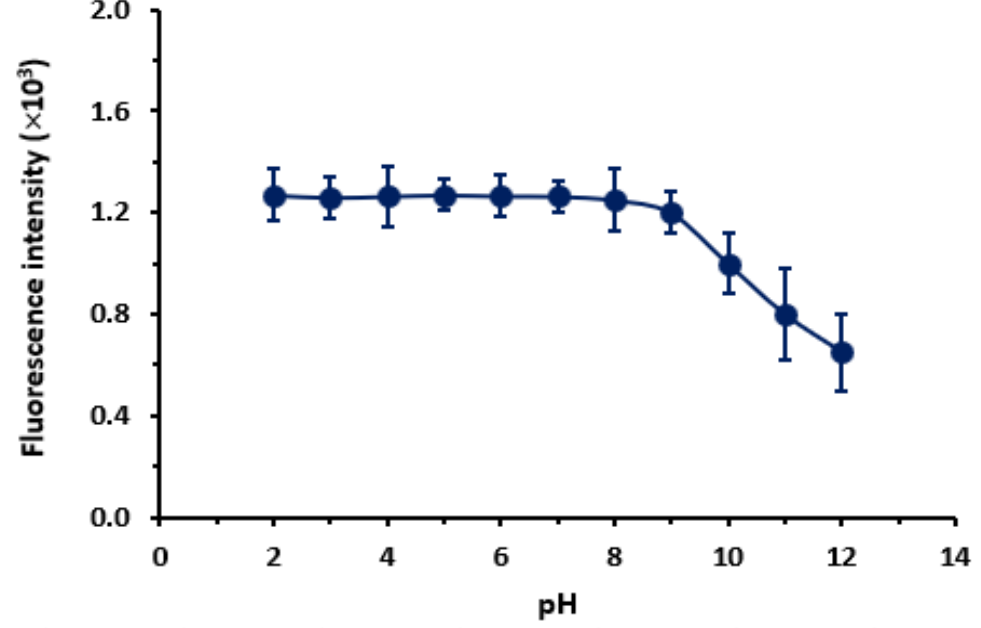
Figure 5. Effect of pH on the fluorescence intensity of PIT solution (1 µ g mL –1 ). Values are mean of 3 determinations ± SD.